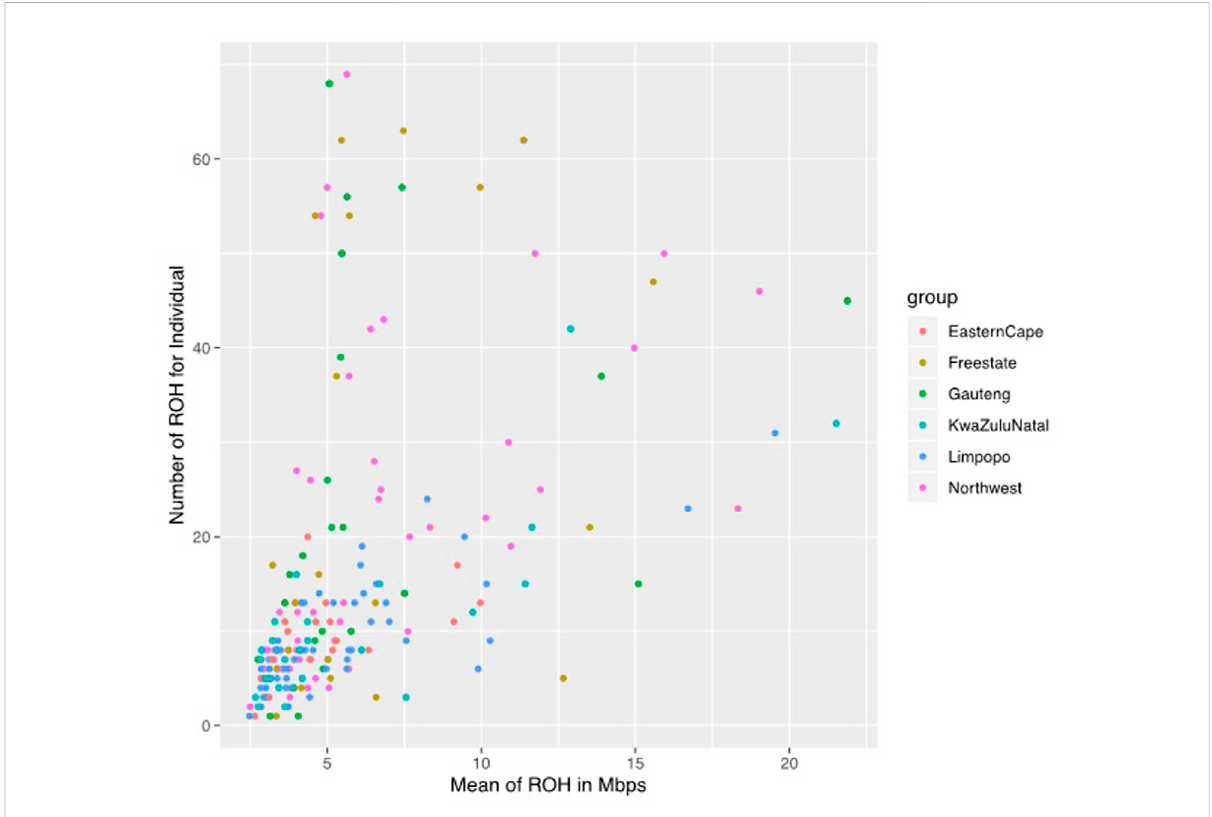
FIGURE 4 The genomic length with mean runs of homozygosity (ROH) per individual and the number of ROH for